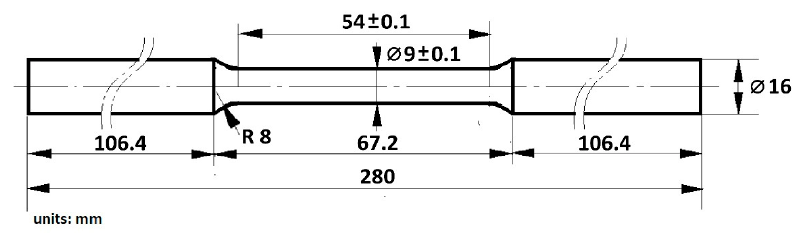
Figure 2. Dimensions of tensile test specimen based on ASTM E8M.